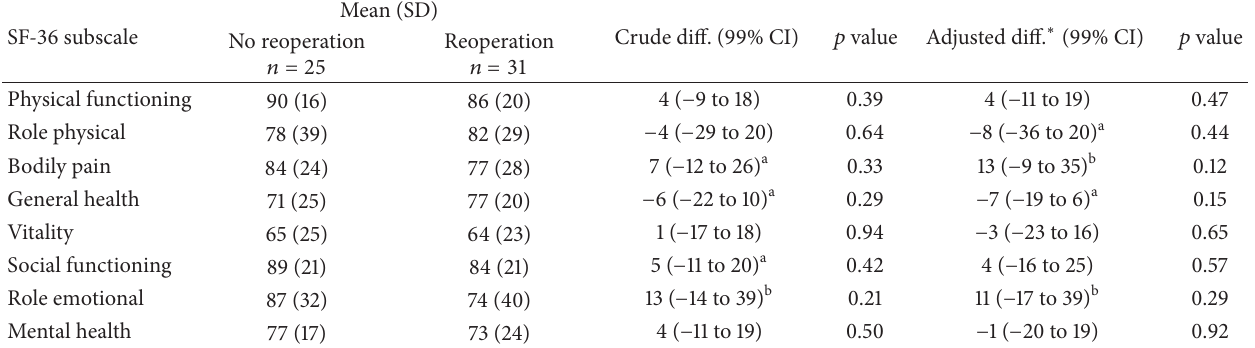
Table 3: Health related quality of life two years after contralateral prophylactic